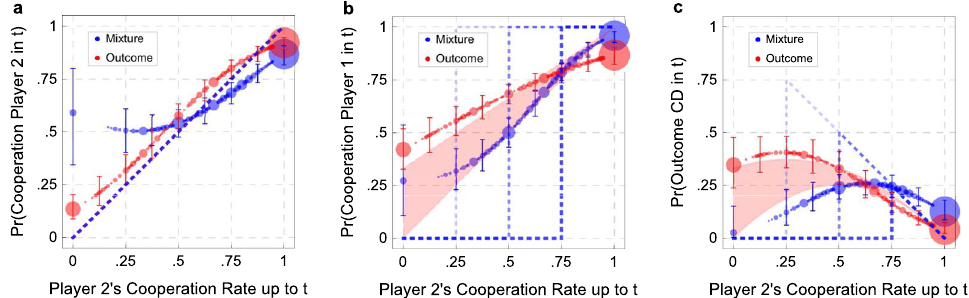
Figure 5. Cooperation rates—direct response method (DRM). On the x-axis we put the frequency with which a given Player 2 chose C in the first t − 1 rounds. On the y-axis we put: the probability with which he chose C at round t ( a ); the probability with which the Player 1 he interacted with at round t chose C ( b ), and the probability of observing the outcome CD at round t ( c ). Dots’ size is proportional to the number of occurrences of that data point. The red areas and the blue dotted lines correspond to our theoretical predictions for the Outcome and Mixture treatments, respectively. The results are in broad agreement with our theory, with an important difference: in the Outcome treatment, Players 2 that played C with a probability smaller than 0.5 induced a larger than expected rate of cooperation. Detailed estimation procedures, results, and raw data are reported in Supplementary Information 1. n(Mixture) = 551; n(Outcome) =